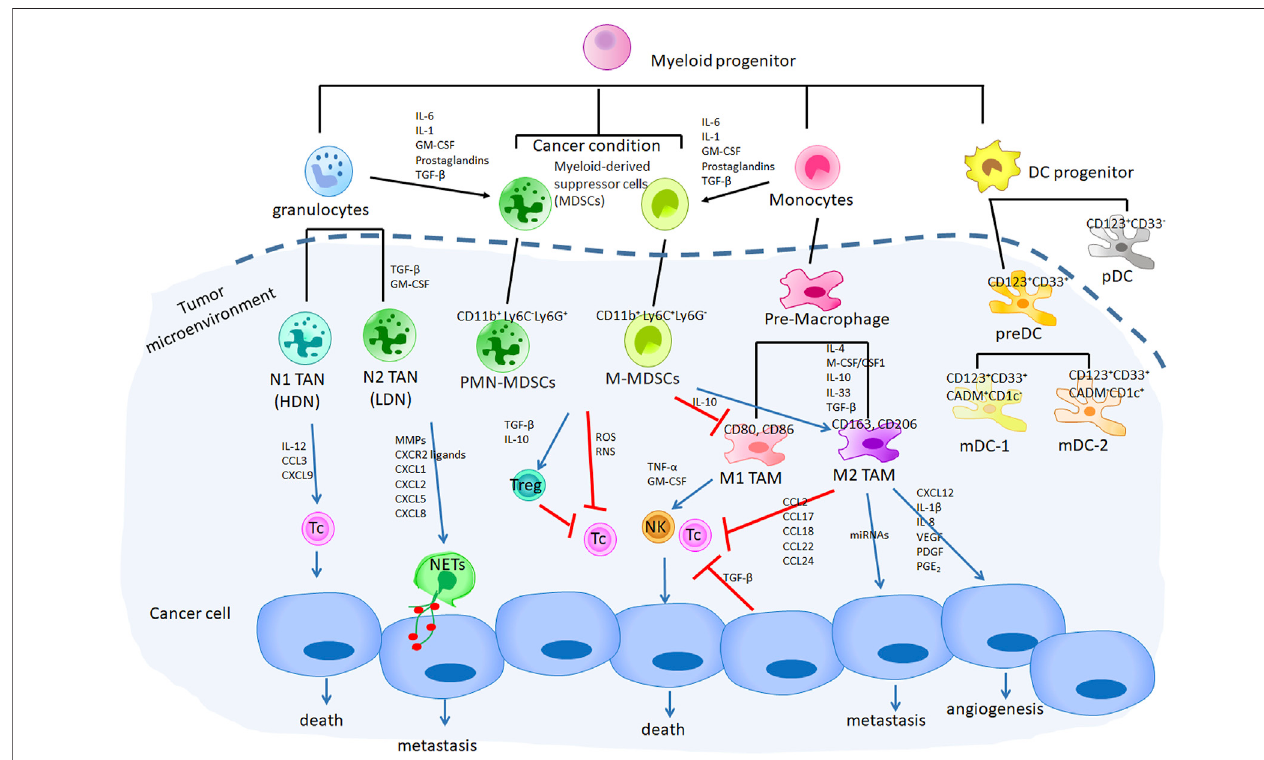
FIGURE 1 | The role of myeloid cells in cancer progression through directly with cancer cells and indirectly regulated cancer immune evasion that promotes tumor growth. Cancer cellsproduce secretometoinducedmyeloidprogenitorcells toform MDSCs and accumulated withinthe TME,whichregulatedTANs and TAMs switch to an anti-in fl ammatory status (N2 TAN and M2 TAMs). N2 TAN (PMN-MDSCs) directly induced NETs through CXCR2 pathway to promote cancer metastasis. M2 TAMs-related CXCL12, IL-1 β , IL-8, VEGF, PDGF, PGE2 as well asmiRNA regulated cancer angiogenesis and metastasis. In addition, both MDSCs and M2 TAMs induced Tregs generation and inhibited cytotoxic T and NK cells activity through their-related soluble factors.